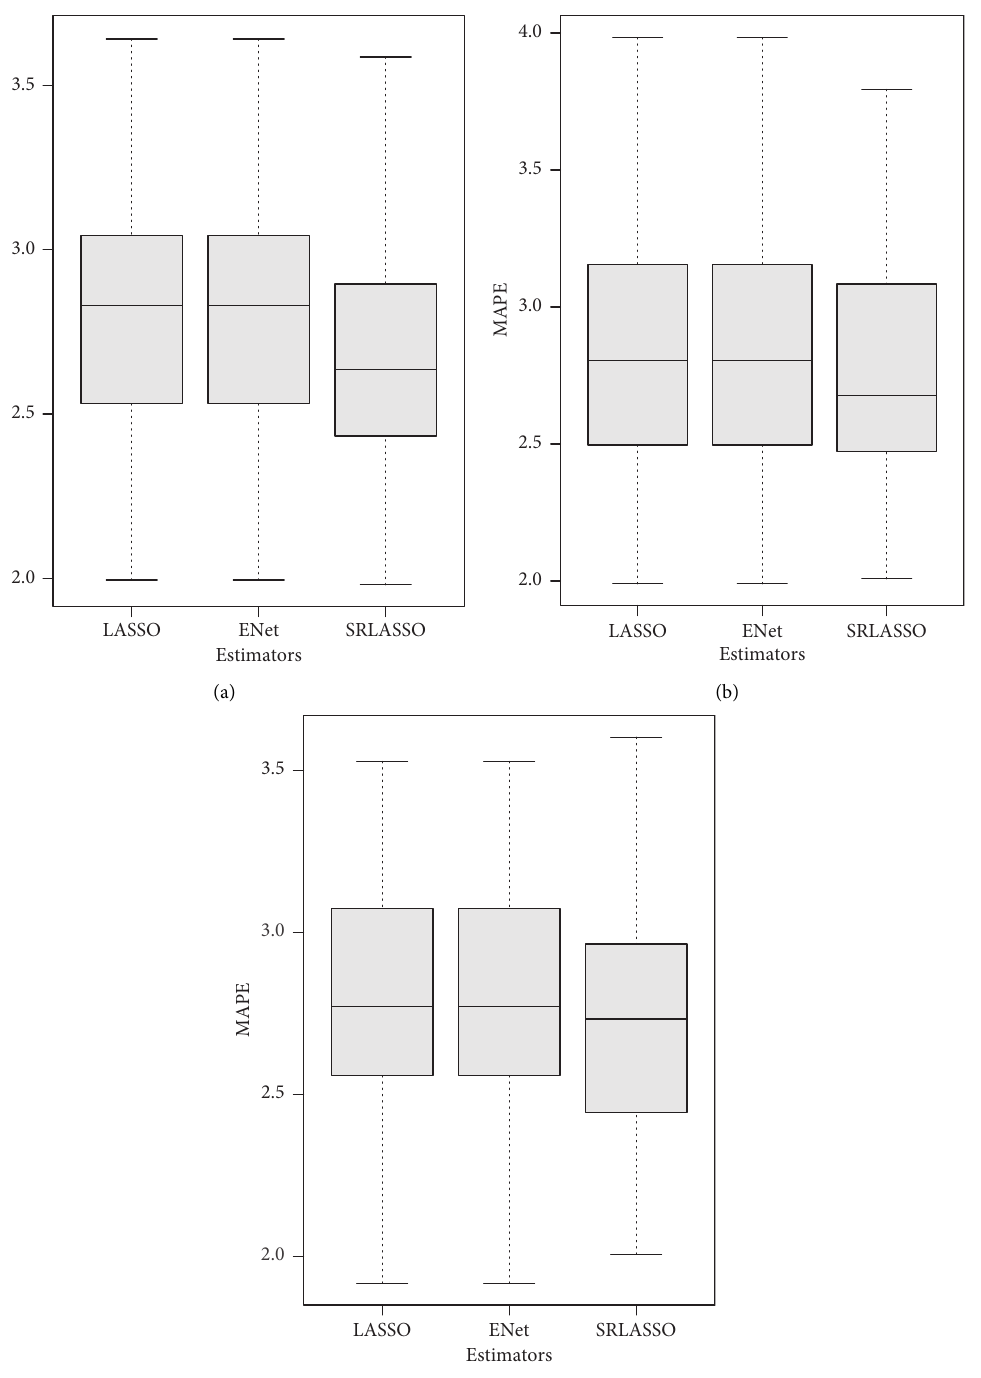
Figure 2: Cross-validated MAPE values of the estimators when (a) ρ � 0.5, (b) ρ � 0.7, and (c) ρ �